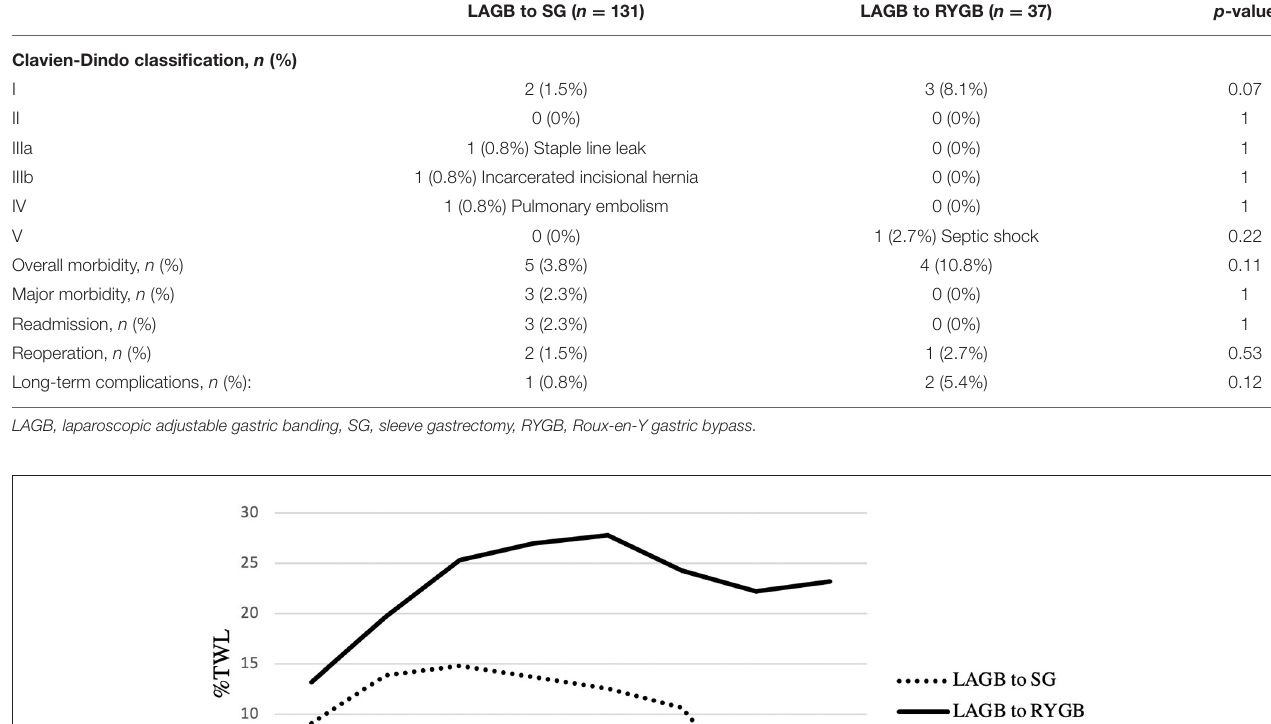
TABLE 4 | Postoperative outcomes in LAGB to SG vs. LAGB to RYGB. LAGB to SG ( n = 131) LAGB to RYGB ( n = 37) p -value